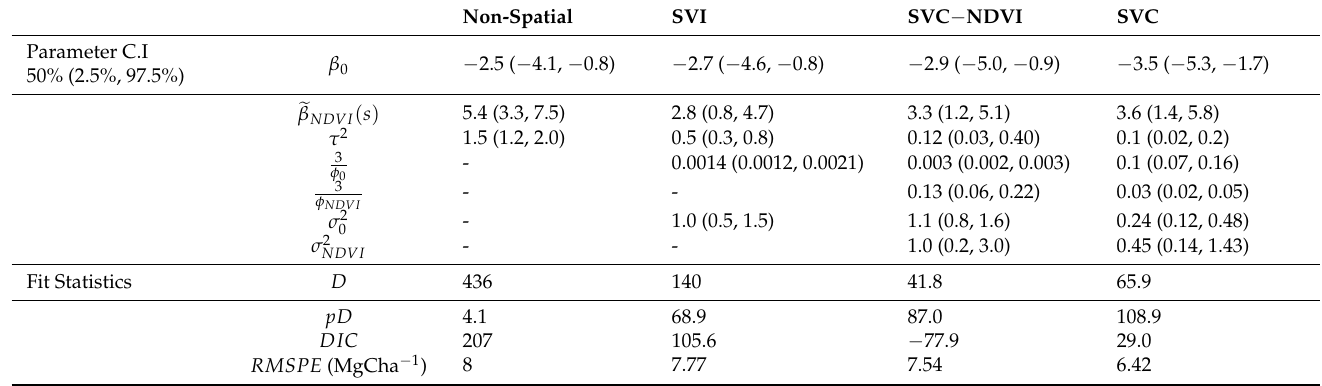
Table 2. Landsat-8-based SVC model median parameter estimates alongside their 95% credible intervals.